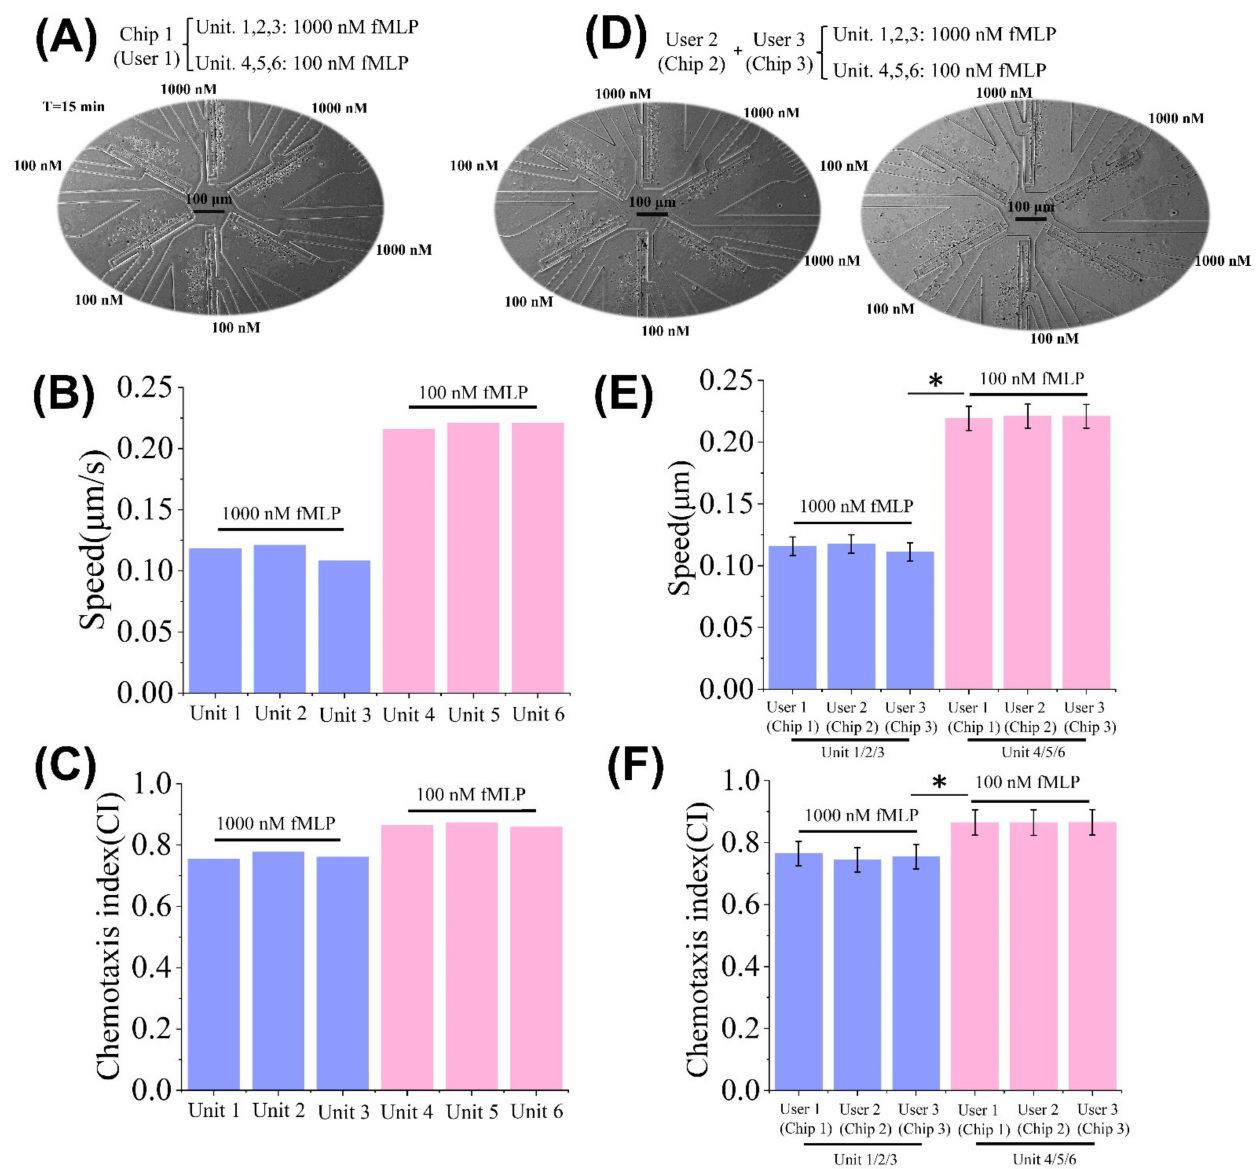
Figure 4. Validation of all-on-chip chemotaxis tests. ( A ) Experiment images in the SC 2 chip after 15 min. ( B ) The migration speeds of magnetically sorted neutrophils in different units. ( C ) The CI of magnetically sorted neutrophils in different units. ( D ) Experiment setup and images for validating the consistency of different SC 2 chips and user-friendliness. ( E ) The migration speeds of magnetically sorted neutrophils from different users (chips). ( F ) The CI of magnetically sorted neutrophils from different users (chips). The statistical significance was assessed of the difference between two sets of data using the Mann-Whitney test. * means a significant difference ( p <